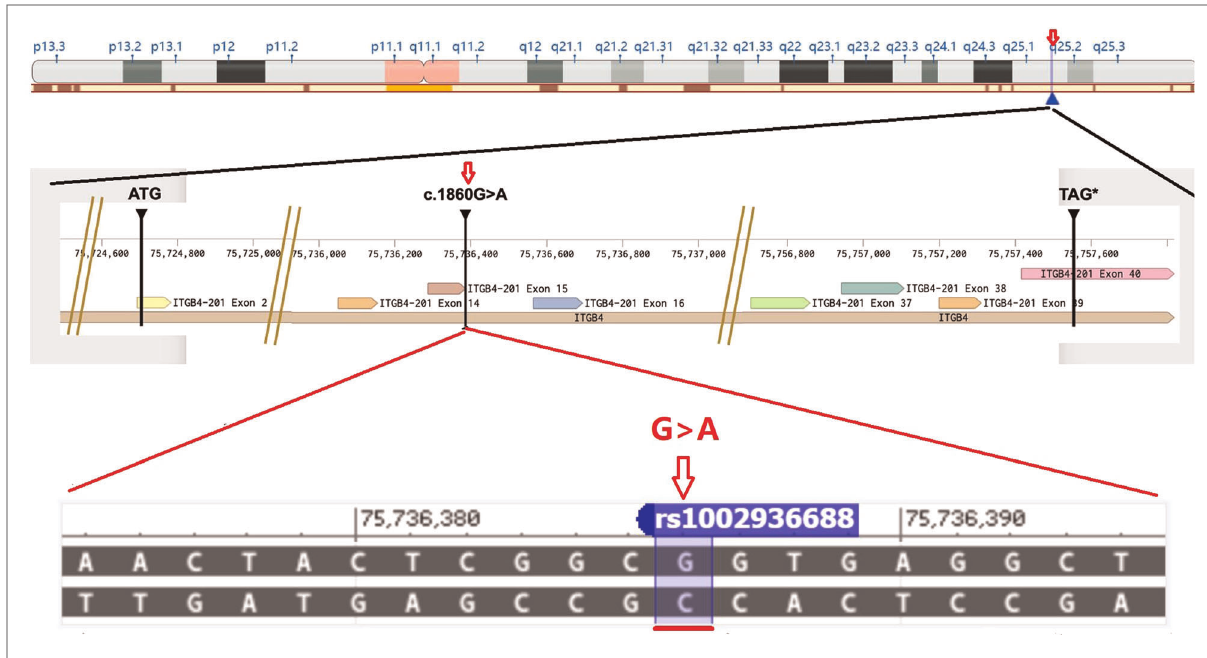
FIGURE 3 The position of c.1860G>A in the ITGB4 gene at exon intron sequence resolution was showed in graphical